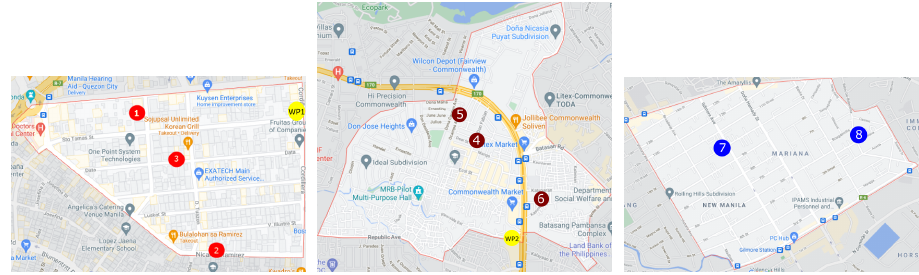
Figure 11. Quezon City map showing the location of the houses with smart bins and the waste- pickers’ homes. Each colored dot indicates a particular location. The red dots belong to cluster c 1 , the dark red ones belong to cluster c 2 and the blue ones belong to c 3 . The waste-picker houses are shown as yellow dots and the dumpsites are depicted as green